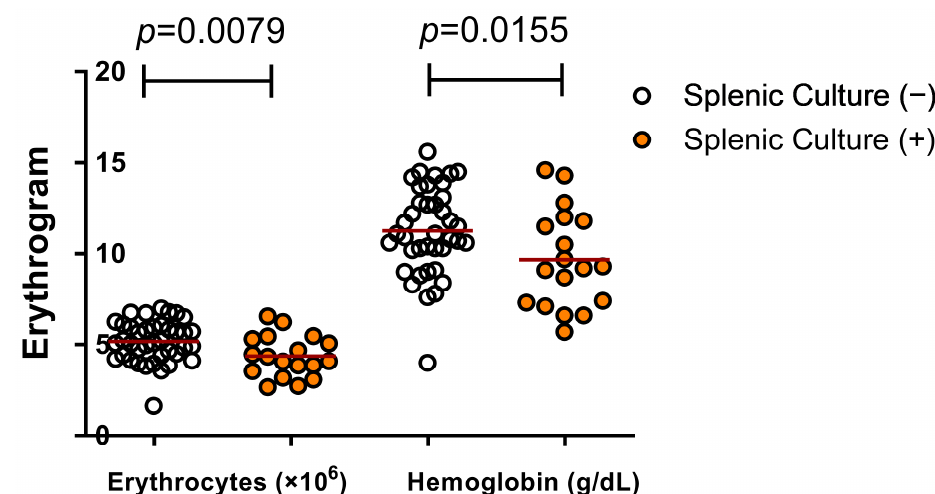
Figure 1. Hematological disorders presented by dogs with positive spleen culture indicating active infection by L. infantum (Student’s t -test).